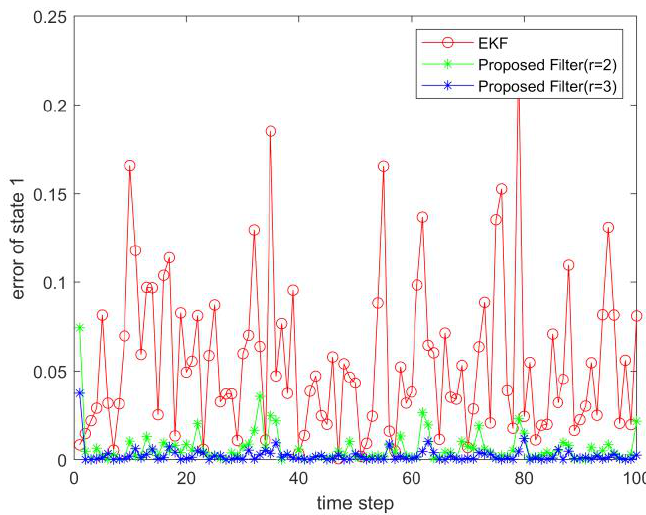
Figure 6. The actual value of state 2 and its estimation.